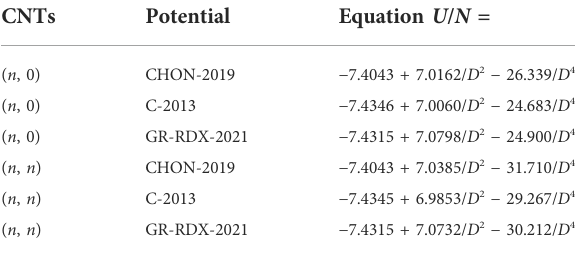
TABLE 2 Fitting functions of the energy per atom U / N of the ( n , 0) and ( n , n ) CNTs for the three ReaxFF potentials. U / N and the CNT diameter D are given in eV and Å units,